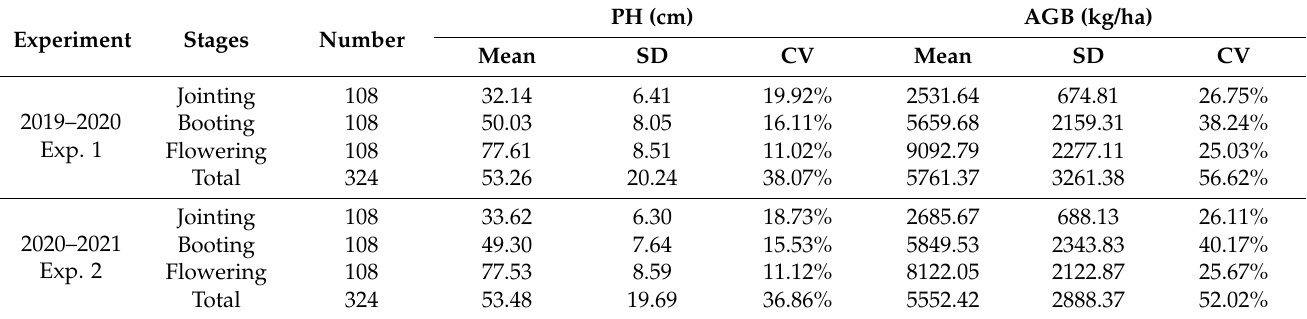
Table 3. Descriptive statistics for PH and AGB from Exp. 1 and Exp. 2 datasets across wheat growth